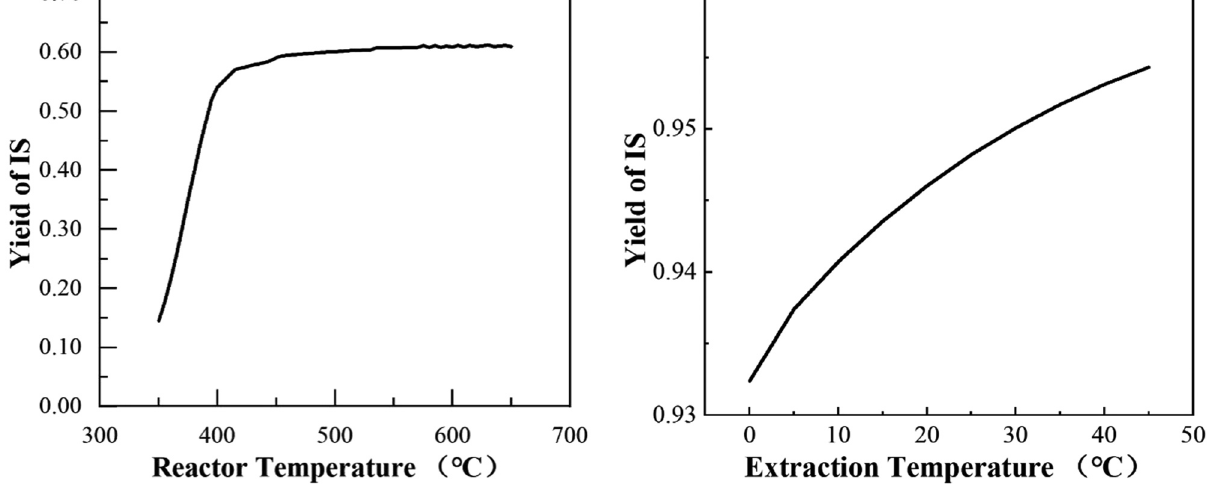
Figure 2: Relationship between the polymerization temperature and the IS yield.